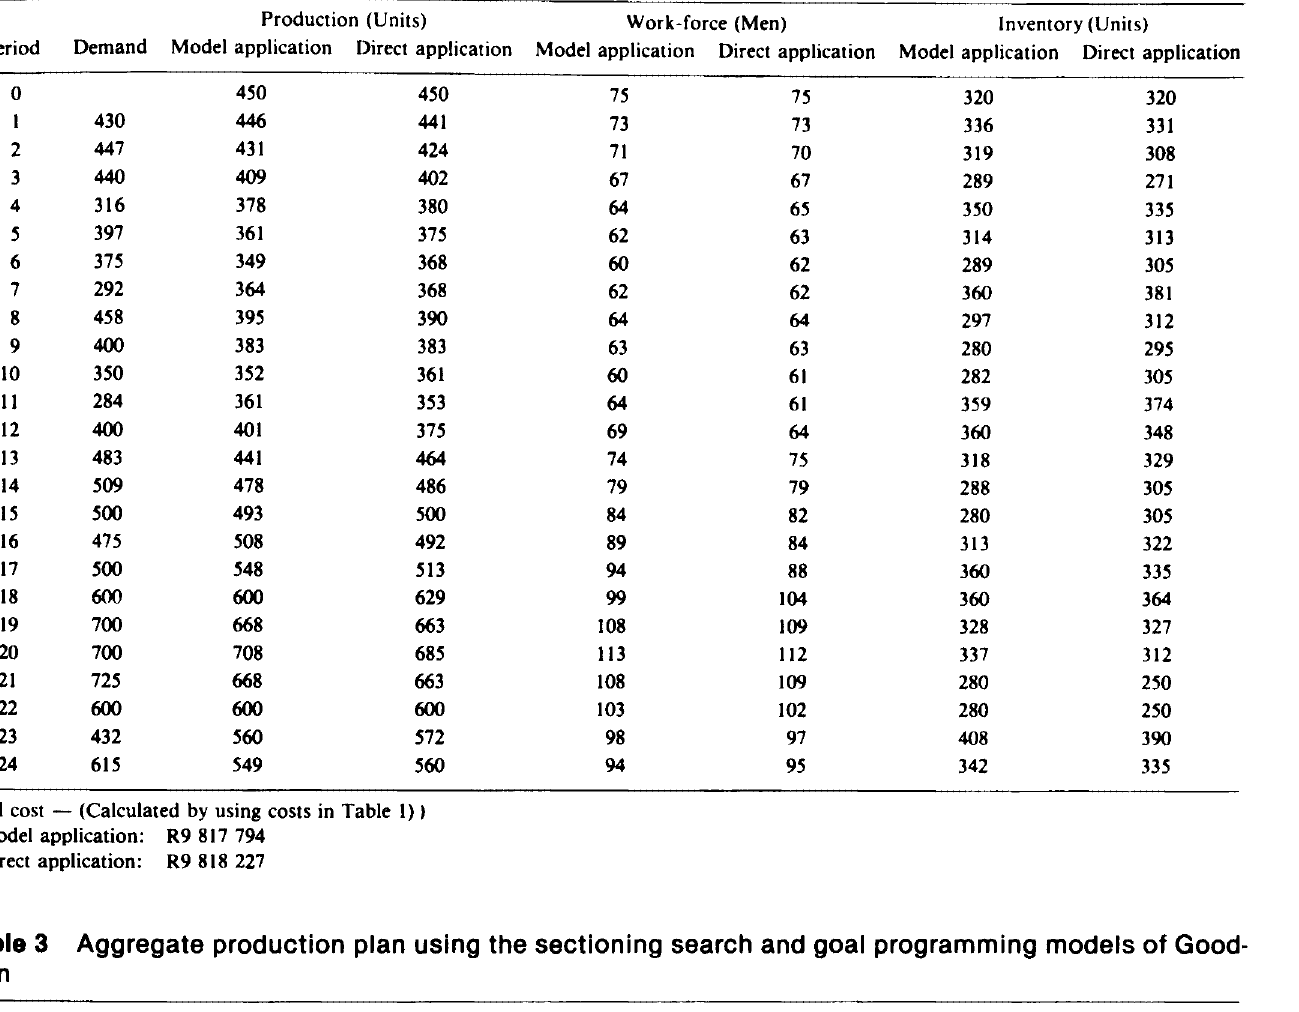
Aggregate production plan using the sectioning search and goal programming models of Good- man Production (Units) Work-force (Men) Inventory (Units